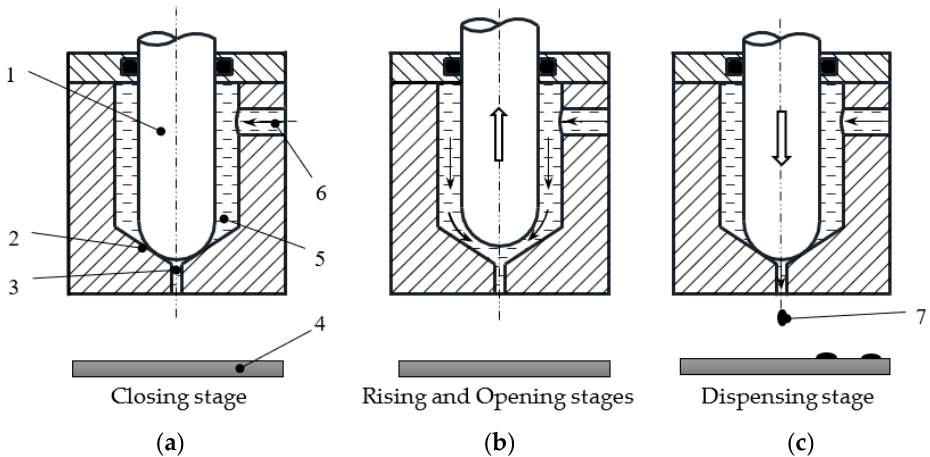
Figure 1. Fluid jetting process. 1. Ball-needle; 2. nozzle-seat; 3. nozzle orifice; 4. substrate; 5. chamber;